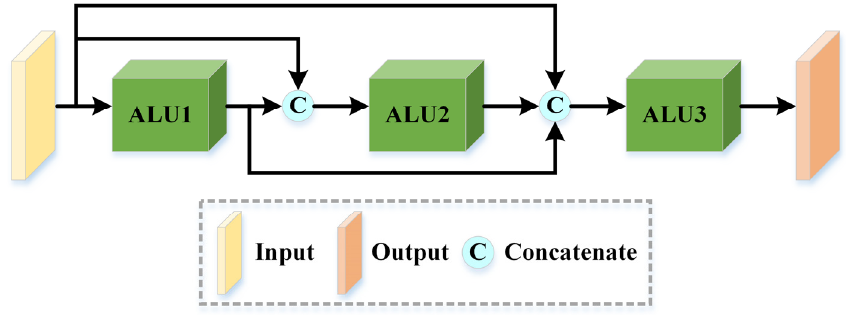
Figure 3. The structure diagram of each branch of cross feature extraction module (CFEM).